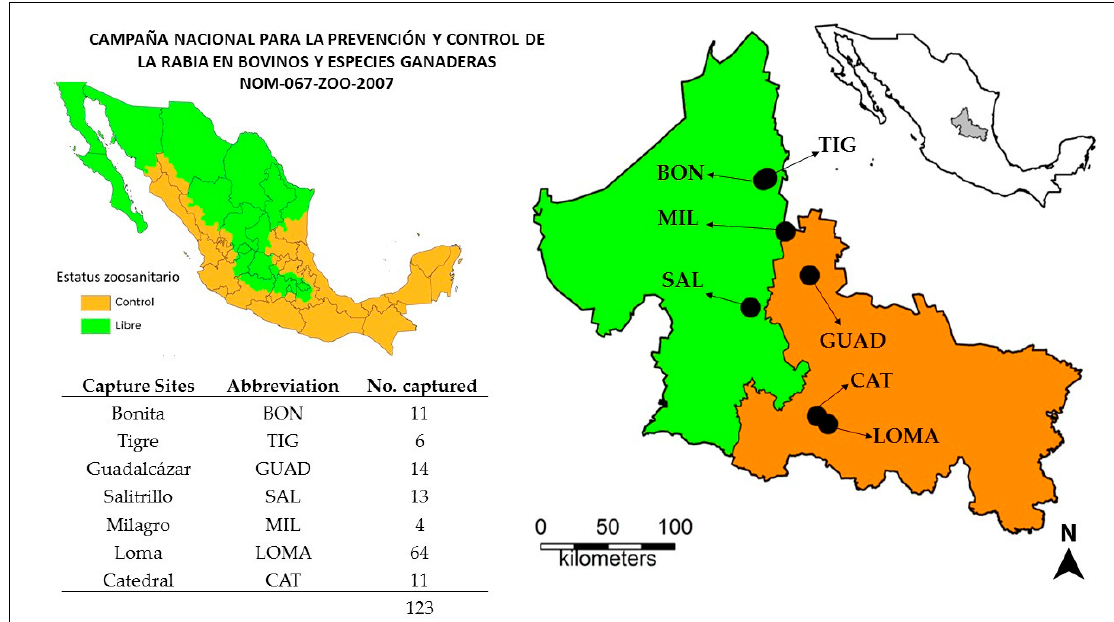
Figure 1. Location of seven capture sites in the State of San Luis Potosí in relation to areas recognized as free (green) or under control (orange) for rabies in livestock species according to the Mexican National Service for Agrifood Health, Safety and Quality (SENASICA) in 2018.